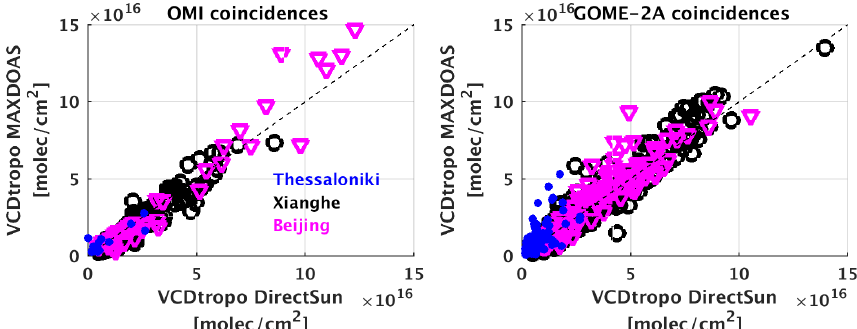
Figure 4. MAX-DOAS and direct sun tropospheric NO 2 columns in Thessaloniki, Xianghe and Beijing. At these sites, ground-based mea- surements are performed in both